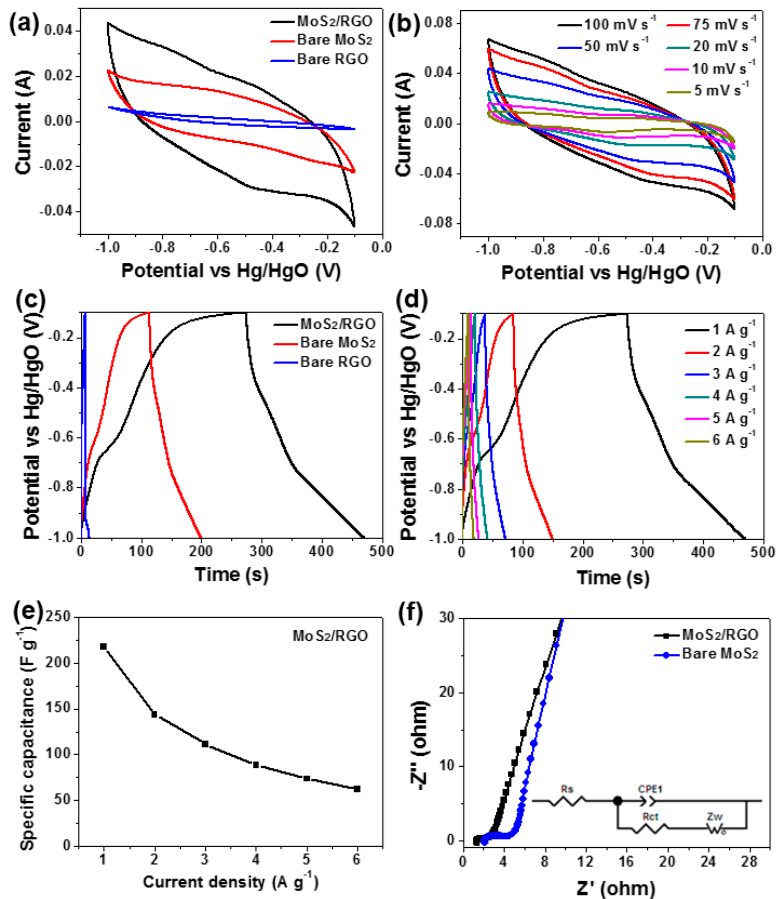
Figure 7. ( a ) CV curves of MoS 2 /RGO hollow microspheres, bare MoS 2 microspheres and bare RGO material at the sweeping rate of 50 mV·s − 1 in 2 M KOH; ( b ) CV curves of MoS 2 /RGO hollow microspheres at different scanning rates in 2 M KOH; ( c ) GCD curves of MoS 2 /RGO hollow microspheres, bare MoS 2 microspheres, and bare RGO material at the current density of 1 A·g − 1 ; ( d ) GCD curves of MoS 2 /RGO hollow microspheres at varied current density ranging from 1 to 6 A·g − 1 ; ( e ) C s of MoS 2 /RGO hollow microsphere electrode obtained from the GCD curves shown in ( d ) as a function of current density; ( f ) Nyquist plots of MoS 2 /RGO hollow microsphere (black curve) and bare MoS 2 microsphere electrodes (blue curve) tested in 2 M KOH in the frequency range from 10 − 2 to 10 5 Hz; the inset is the equivalent circuit used to fit the Nyquist spectra.